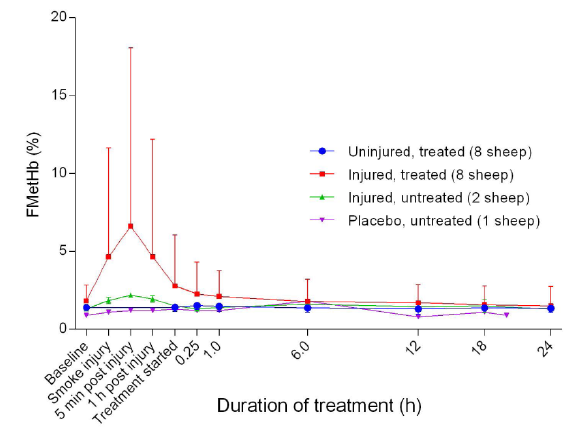
Figure 11. Fraction of methaemoglobin (FMetHb) (Mean ± SD) in smoke and non-smoke injured sheep that received extracorporeal life support as compared to that in untreated controls. Error bars are one-sided for clarity.